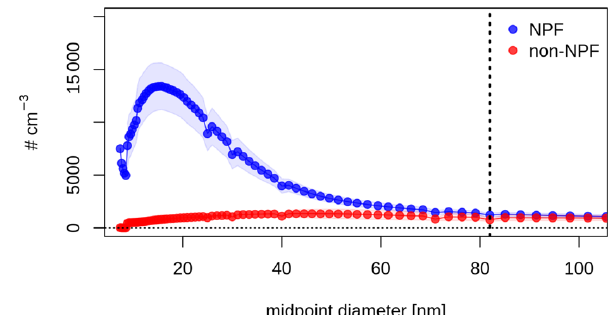
Figure 4. Average number of particles produced at each particle diameter for NPF events (blue) and non-events (red). NPF events produce significantly more particles at aerosol diameters below the vertical line (82.0nm) as determined by a two-sample t test ( p < 0 . 05 indicates